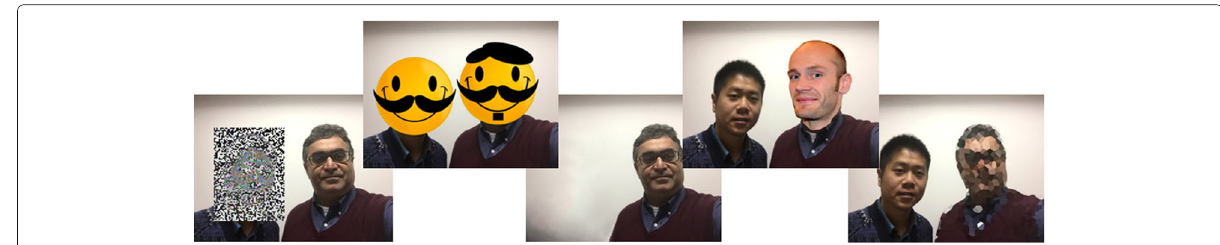
Fig. 4 Examples of secure transmorphing operations applied to an